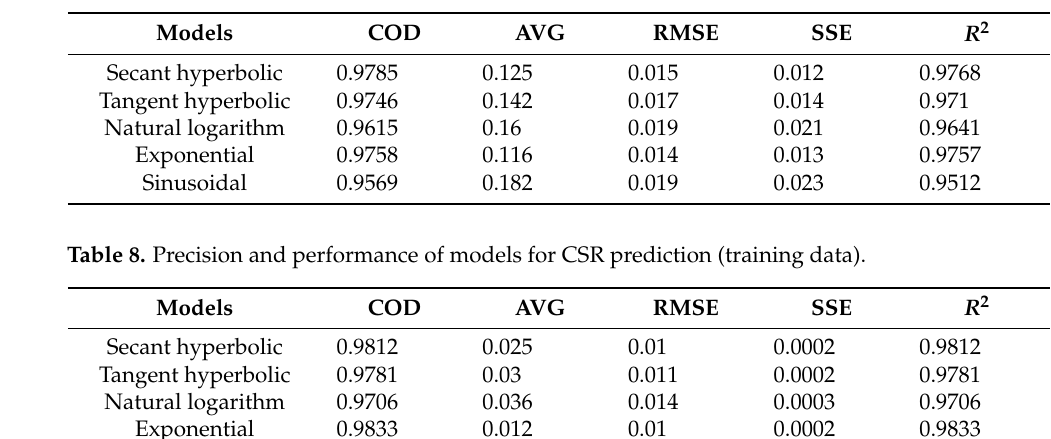
Table 7. Precision and performance of the models for ∆ H prediction (all data).